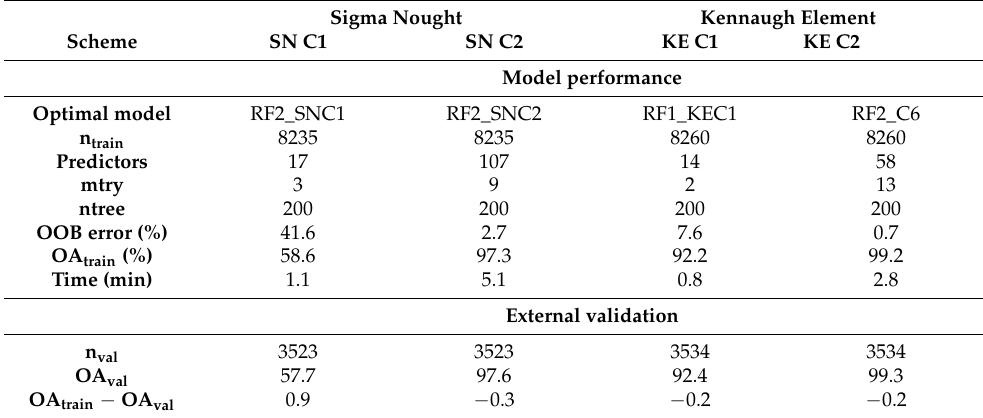
Table 6. Random Forest (RF) model performance for the multi-temporal classification schemes (Table